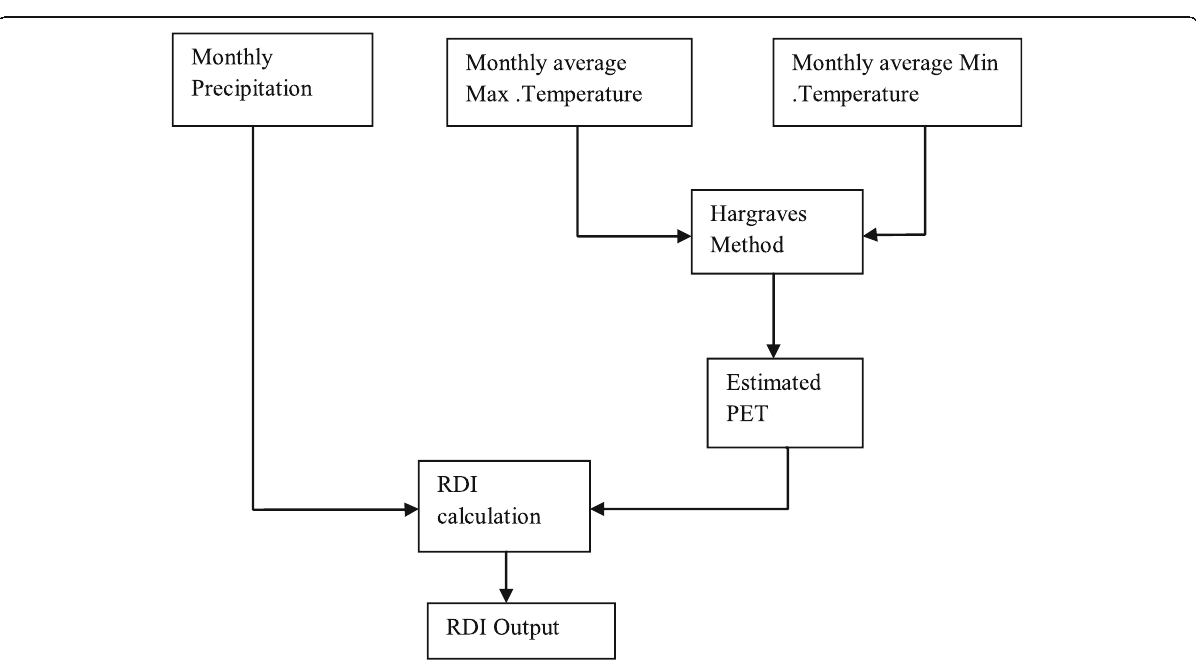
Fig. 2 The flow chart of DrinC software. Source: Adapted from Tigkas et al.